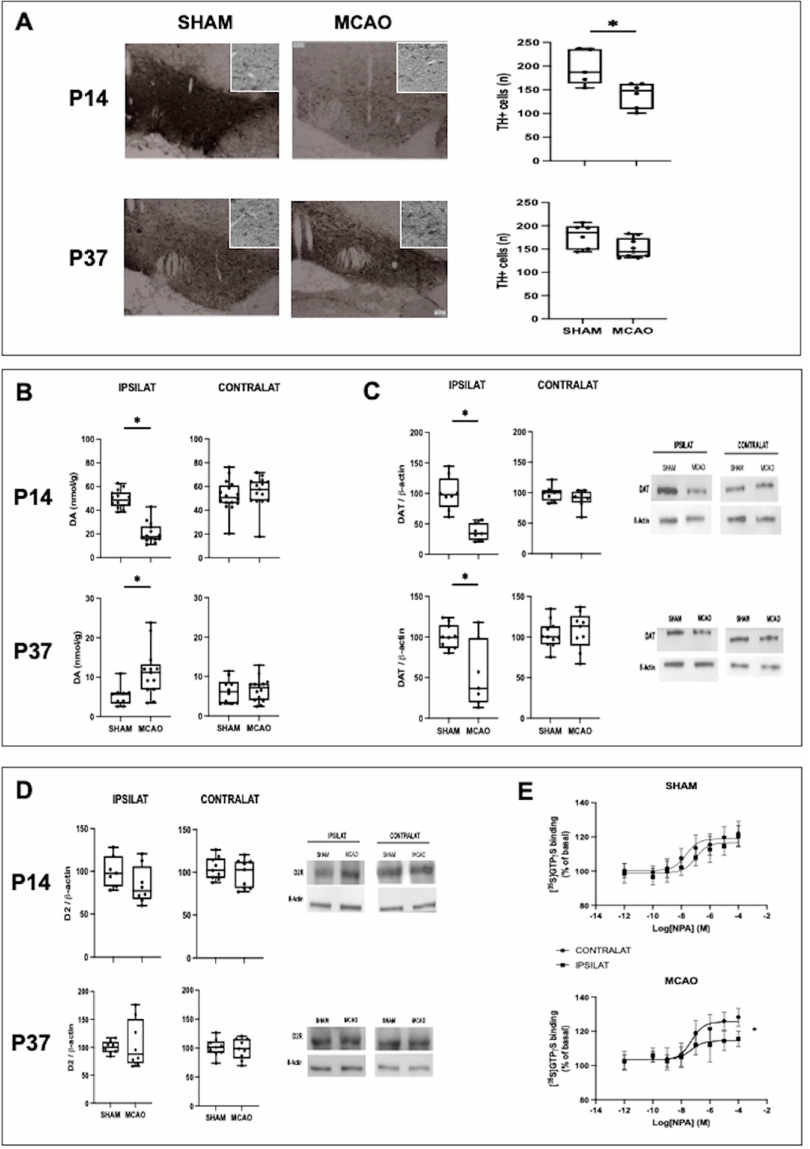
Figure 3. Assessment of the dopamine system in rats submitted to MCAO at seven days of life (P7) and the corresponding healthy controls (SHAM). ( A ) Illustrative photomicrographs of the ipsilateral ventral tegmental area (VTA) after thyroxin hydroxylase (TH) staining and the quantification of the number of TH+ cells in VTA. Original magnification: low magnitude = × 10; high magnitude = ×